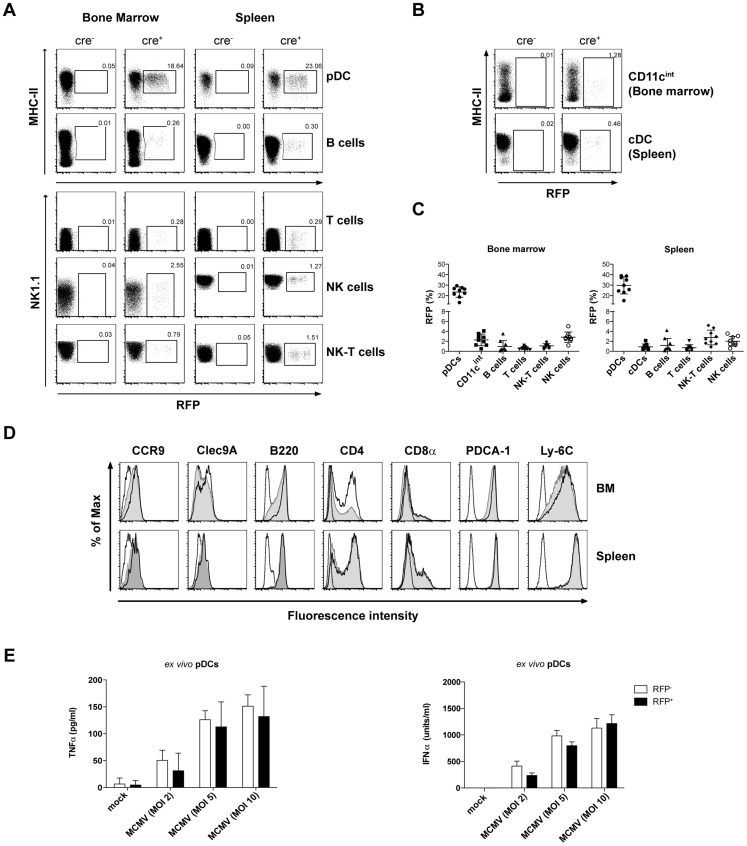
Characterization of the pDCre x RFP reporter line shows terminal targeting of pDCs.(A, B) BM and spleen cells from pDCre x RFP mice were stained for Siglec-H, CD11c, MHCII, CD3ε, CD19 and NK1.1 (A) Characterization of the reporter expression (RFP) by different cell types: pDCs were gated as Siglec-H+, B cells as Siglec-H− CD19+ CD3ε− NK1.1−, T cells as Siglec-H− CD19− CD3ε+ NK1.1−, NK-T cells as Siglec-H− CD19− CD3ε+ NK1.1+, and NK cells as Siglec-H− CD19− CD3ε− CD11cint NK1.1+. FACS plots are representative for two individual experiments. (B) Characterization of the RFP reporter expression by CD11chi MHCIIhi cDCs in spleen and CD11cint CD19− CD3ε− NK1.1− Siglec-H− cells in BM. (C) Quantification of (A, B) showing pooled data from 2 independent experiments using 4–5 mice/group. (D) Phenotypic comparison of pDC markers expressed by RFP− and RFP+ pDCs from BM (top panel) and spleen (bottom panel). pDCs were gated as Siglec-H+ CD11cint. Histogram overlays display the isotype controls as dashed line, and the marker expression by RFP− pDCs as grey filled histogram and by RFP+ pDCs as bold line. Data shown are from one representative experiment out of two using 4 mice/group. (E) Splenic ex vivo pDCs were purified by FACS sorting from B16-Flt3L treated pDCre x RFP mice and incubated with the indicated MOIs of MCMV in vitro. IFNα/TNFα concentrations were quantified in the supernatants after 24 h incubation by ELISA or cytometric bead assay. Data shown are from one representative experiment out of two using a pool of 3 mice. The differences between RFP− and RFP+ pDCs were not significant as calculated by Students t-test. Data displayed in (D, E) are from one out of two individual experiments with similar results. Data are displayed as mean ± SD.